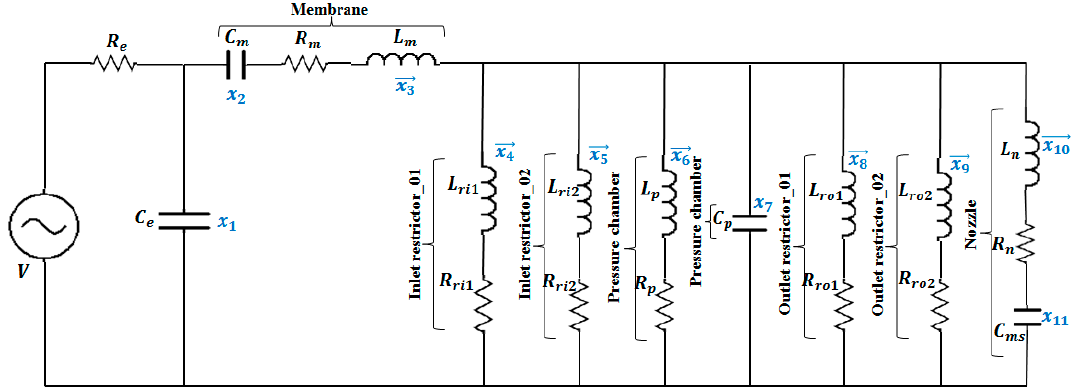
Figure 3. Equivalent circuit model of a D-RPIP design.